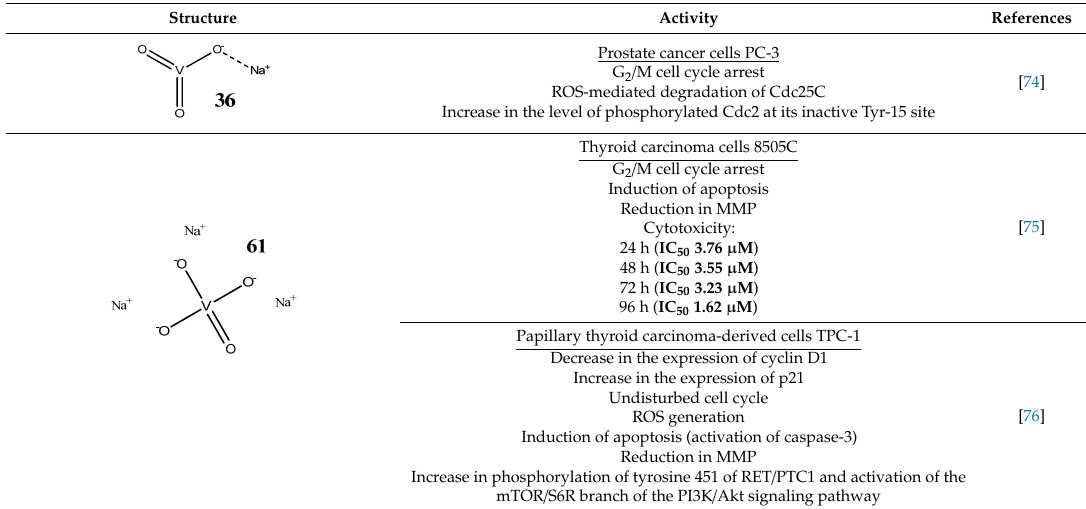
Table 3. Structures and mechanism of action of cell-cycle-disrupting vanadium compounds (ROS, reactive oxygen species; MMP, mitochondrial membrane potential).